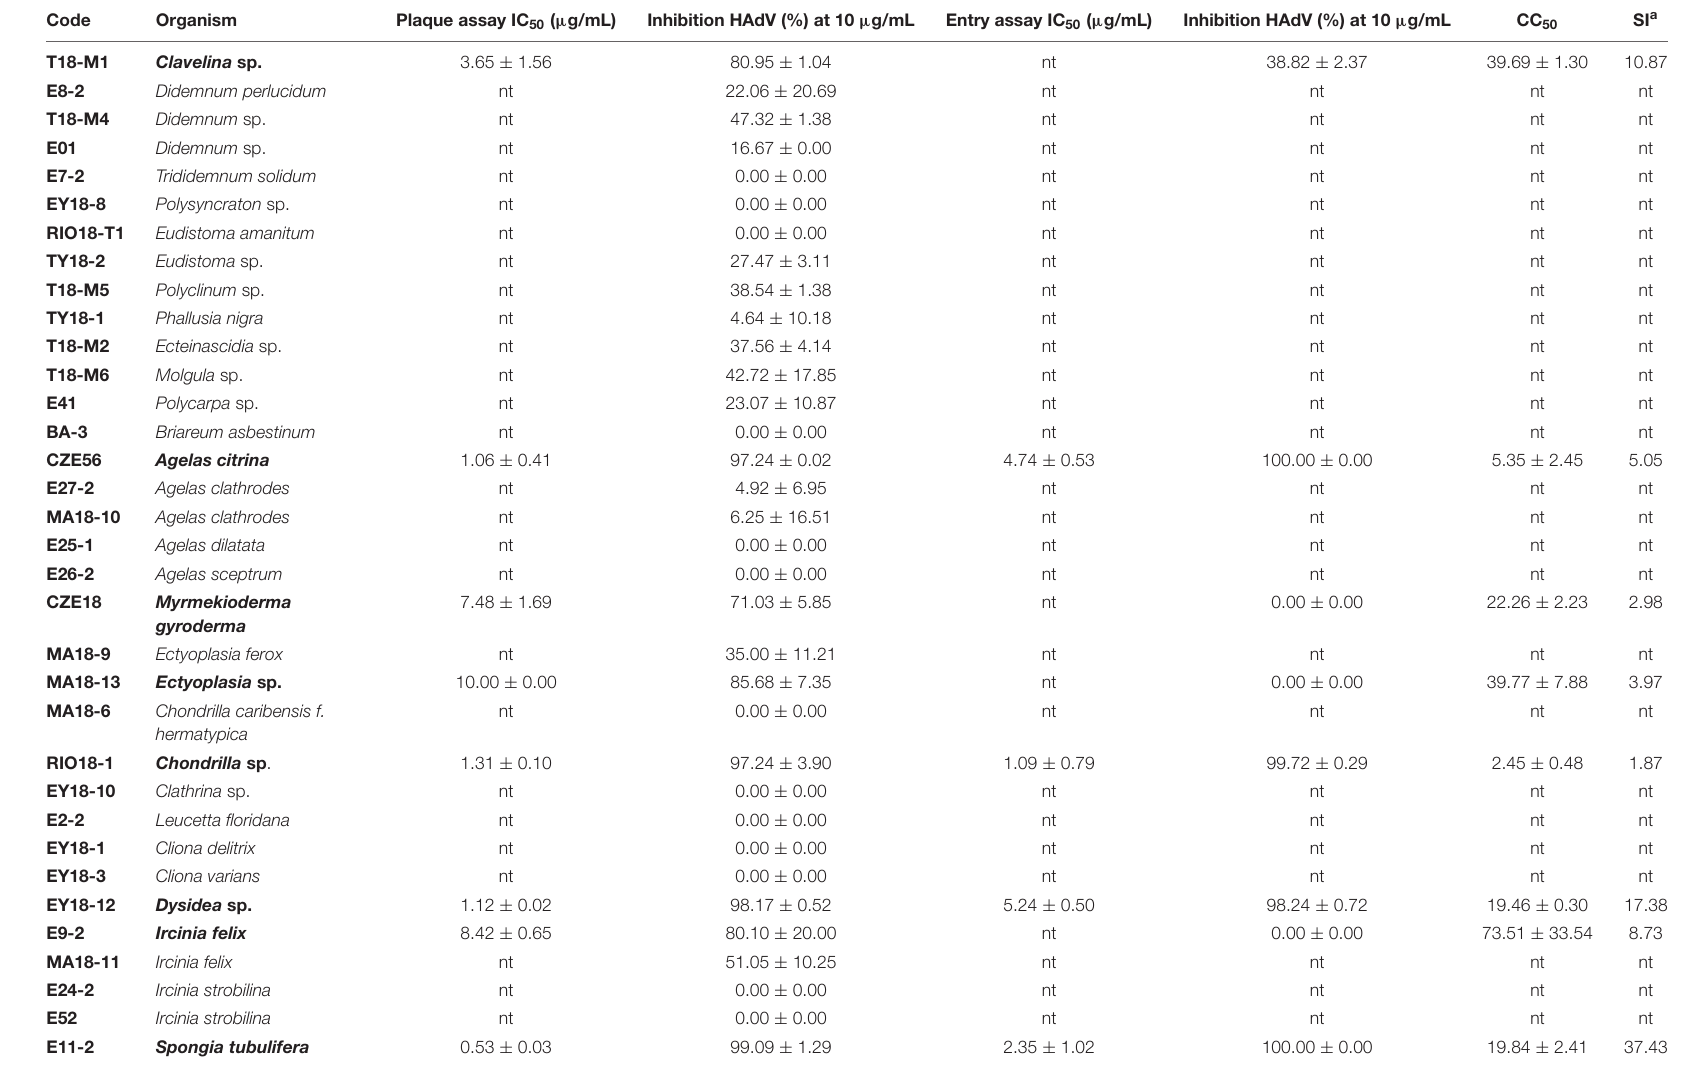
TABLE 2 | IC 50 , CC 50 , SI, % inhibition of HAdV infection and % inhibition of HAdV entry of organic extracts of marine organisms from the Yucatan